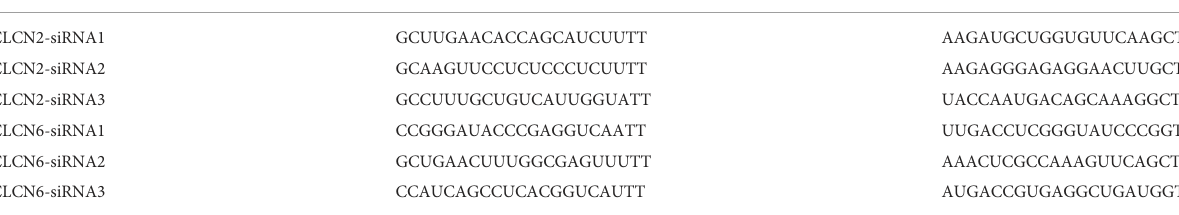
TABLE 2 siRNA sequences of CLCN2 and